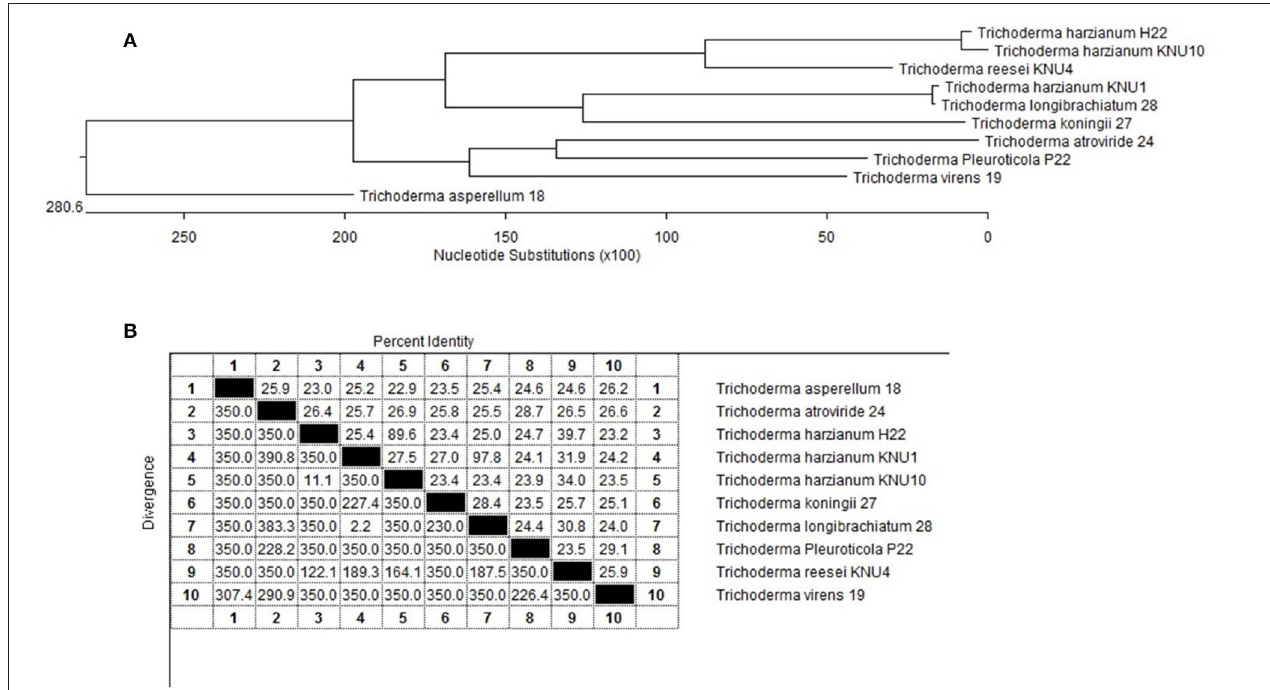
FIGURE 5 | Phylogenetic analysis of the selected Trichoderma spp. rhizosphere strains; (A) The phylogenic tree showing the lengths of the upright lines are arbitrary; the lengths of the transversal lines are proportional to genetic distances. Bootstrap frequencies are given for a multiple data set of 100 trials; (B) 18s rRNA gene sequence similarity for the isolated plant-growth promoting Trichoderma